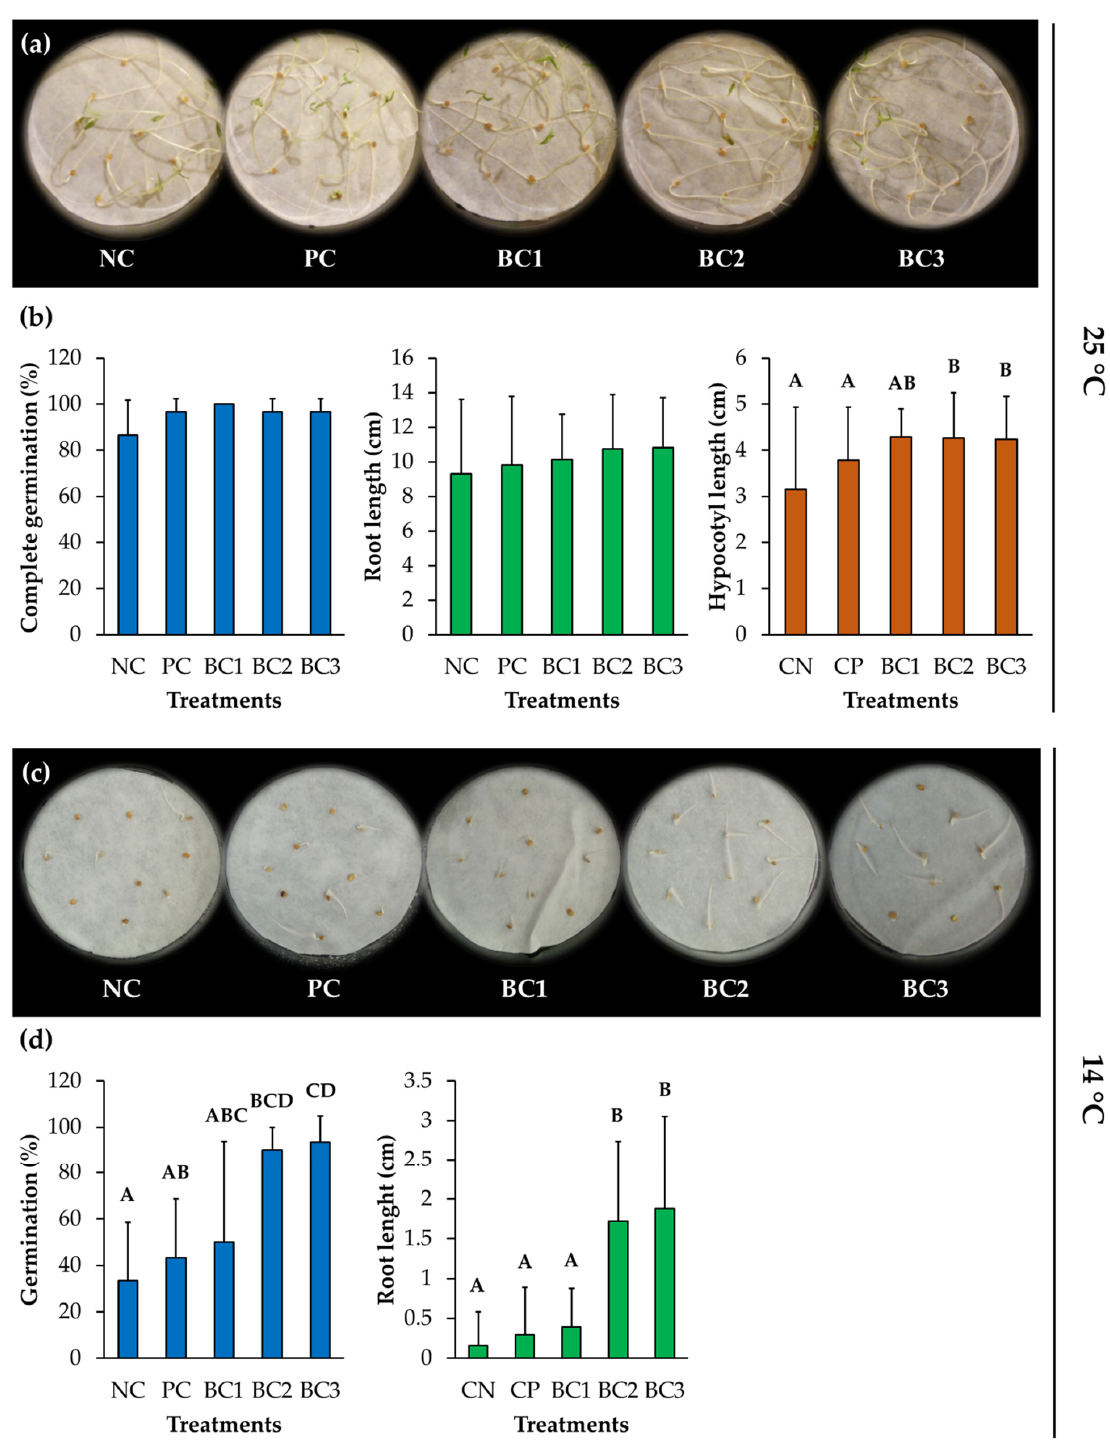
Figure 7. Effect of selected bacterial consortia on the growth of tomato seeds at 25 and 14 ◦ C in the biopriming assay. ( a ) Representative photograph of tomato seed growth inoculated with selected consortia at 25 ◦ C. ( b ) Graphs of evaluated parameters of tomato seeds growth at 25 ◦ C. ( c ) Representative photograph of tomato seed growth inoculated with selected consortia at 14 ◦ C. ( d ) Graphs of evaluated parameters of tomato seeds growth at 14 ◦ C. Each value is a mean ± SD of three independent replicates, with a total of 30 seeds per treatment. Significant differences were analyzed by the Kruskal–Wallis test followed by all pairwise multiple comparisons. Means with different letters indicate significant differences ( p < 0.05). Abbreviations: NC, negative control; PC, positive control (Nutrisac); BC1-3, bacterial consortium 1, 2, and 3, respectively.